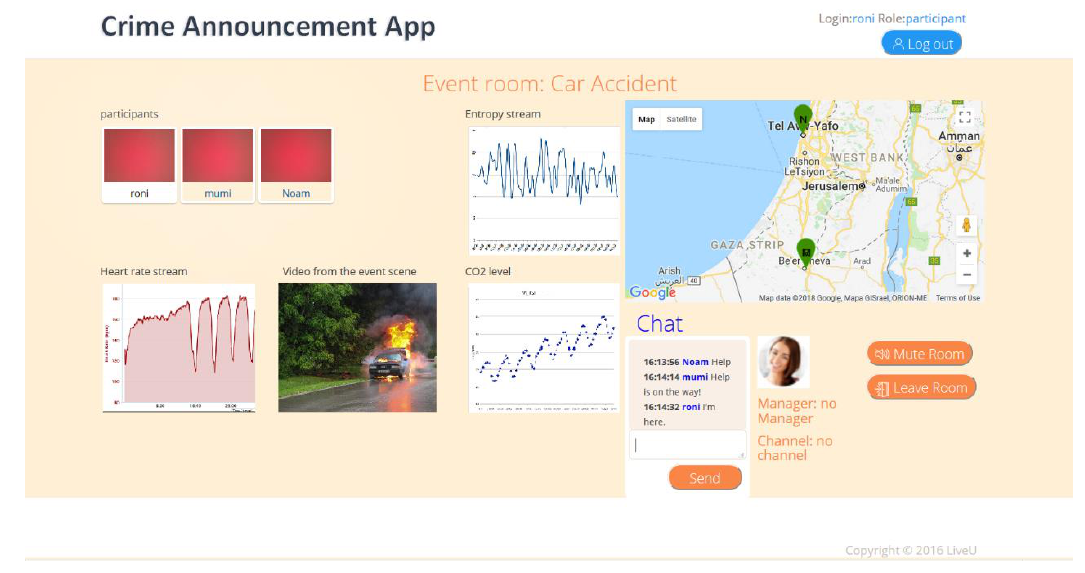
Figure 30. A view of the screen of the authorities of the traffic accident area after the alarm event.